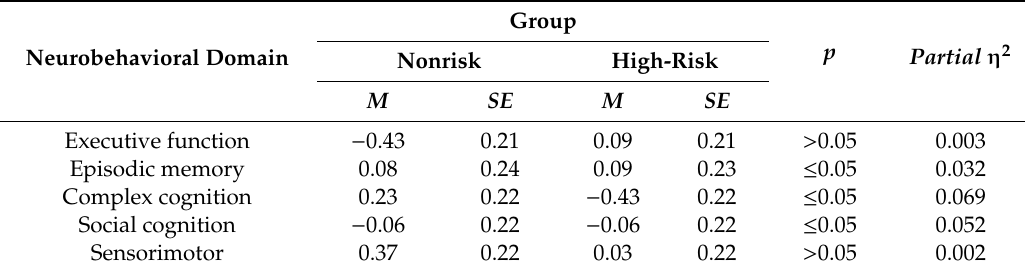
Table 3. Speed neurocognitive performance scores by group.